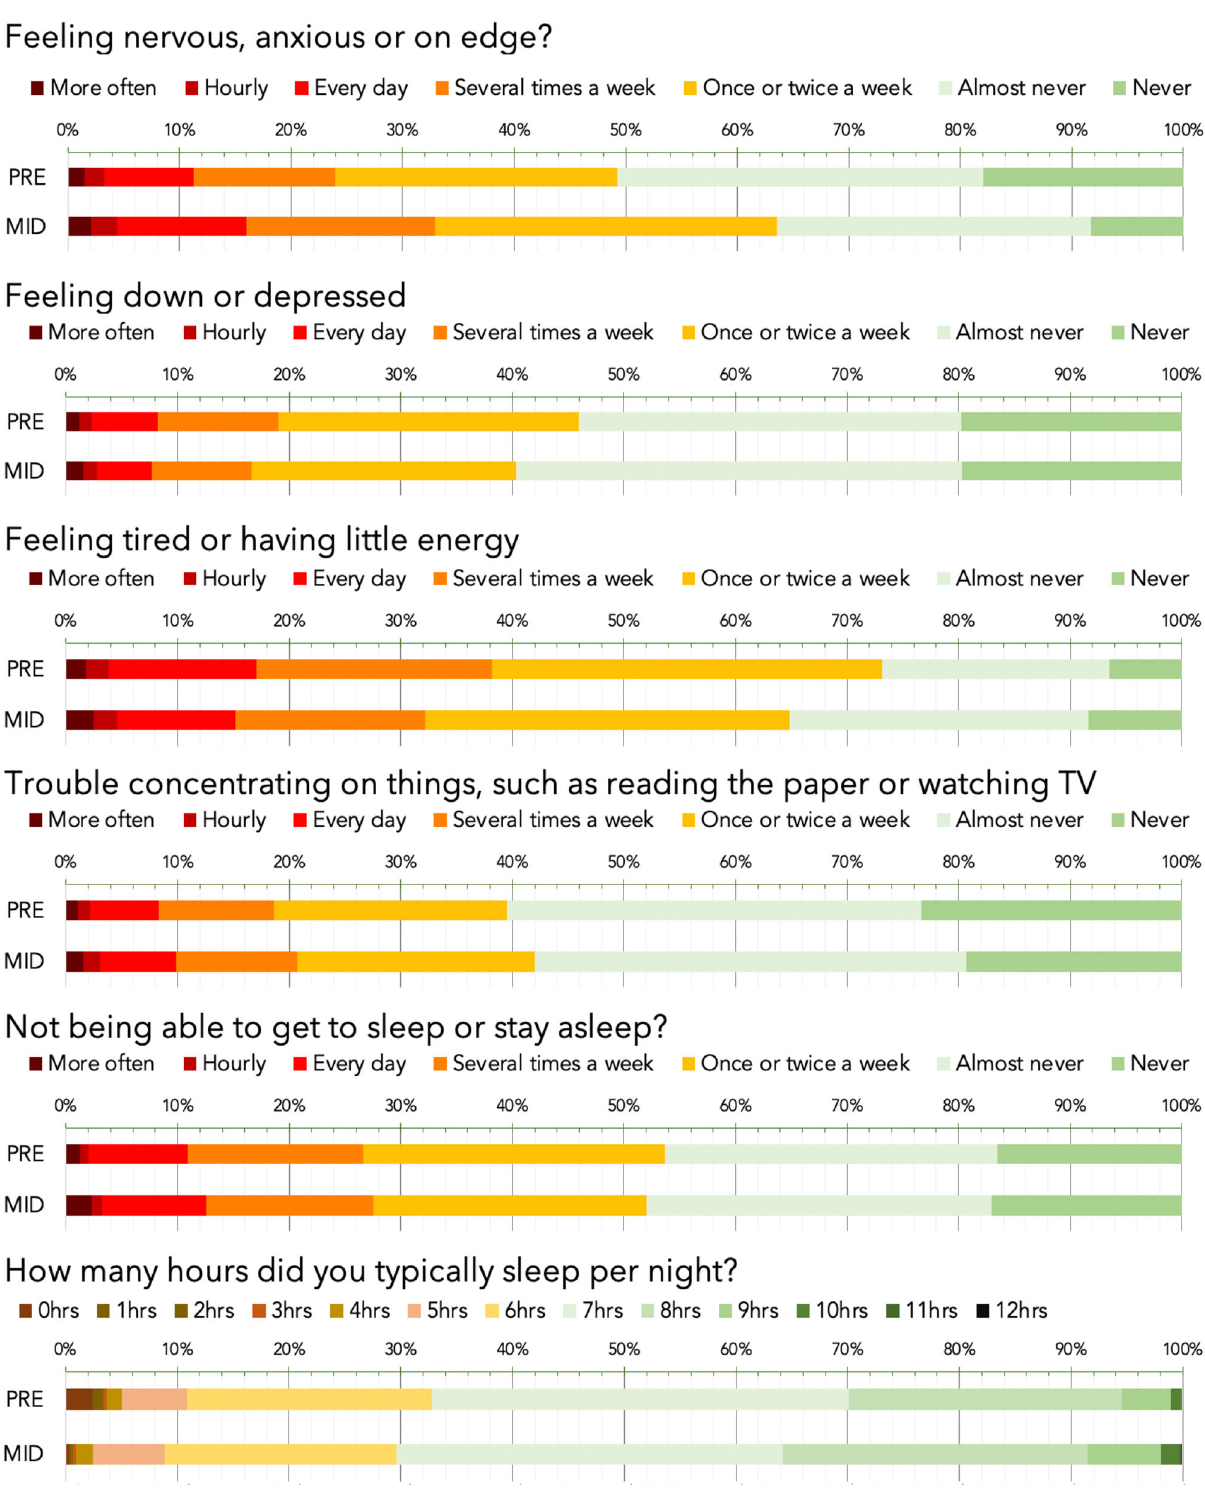
The correct version of Fig. 2